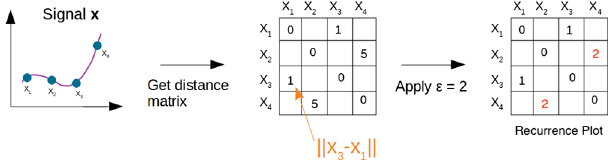
FIG. 7. Generation of recurrence plot from a signal with fixed ϵ ¼ 2 (from [66], Fig. 7).